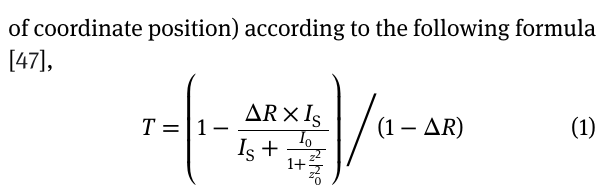
Figure 3: Band structure calculation.